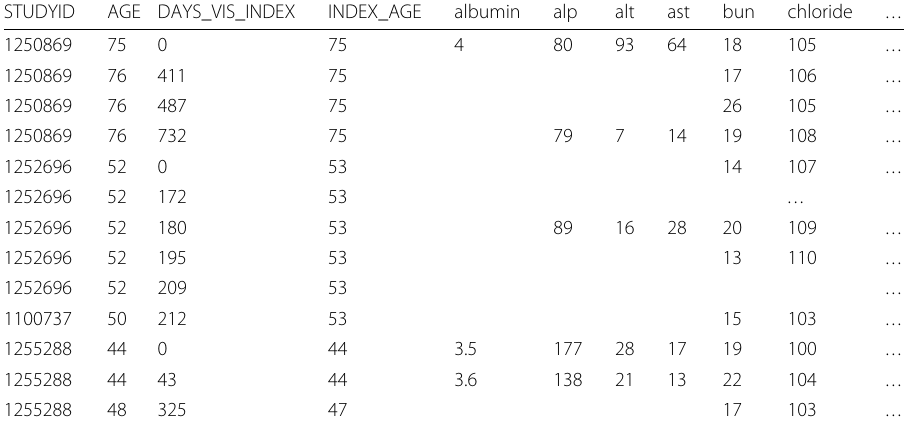
Table 4 The clinical variables file contains measurements regarding blood and urine samples during a patient visit, along with the patient age during the visit, the age at which they were diagnosed with diabetes, and the number of days after the first diabetes diagnosis the visit occurred